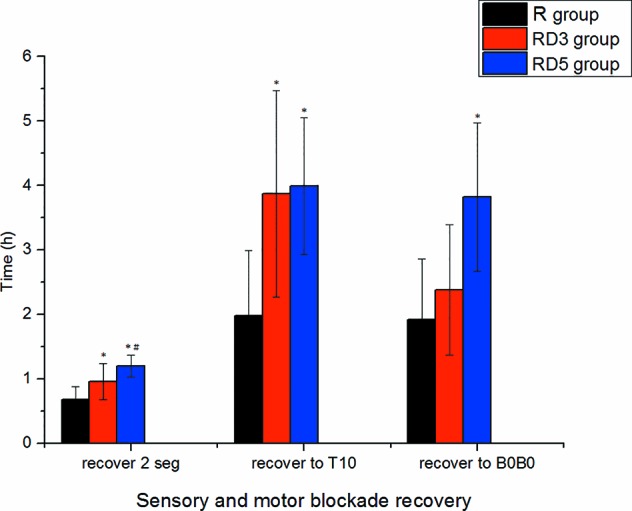
Recovery time of sensory and motor block. *p < 0.05 was considered statistically significant compared with the R group. #p < 0.05 was considered statistically significant compared with the RD3 group.